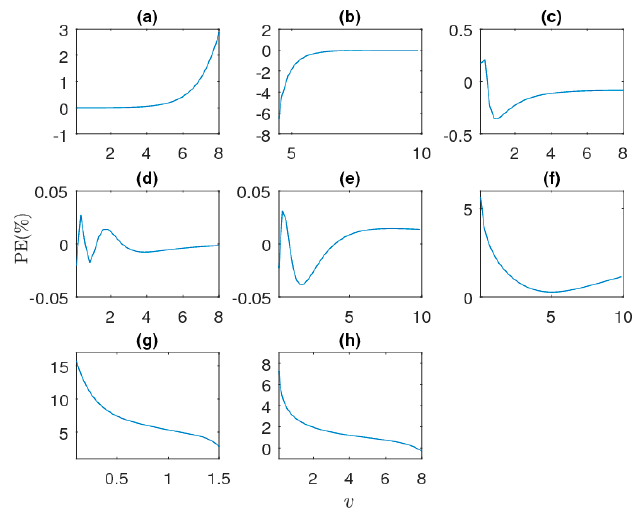
Figure 12. Percentage errors of the approximations: ( a ) Equation (35) with 40 terms, ( b ) Equation (38) with 10 terms, ( c ) Equation (39) [12], ( d ) Equation (42) [13], ( e ) Equation (45) [14], ( f ) Equation (64) (10th-order HAM solution), ( g ) Equation (78) (four-term HPM solution), and ( h ) Equation (87) (three-term OHAM solution).